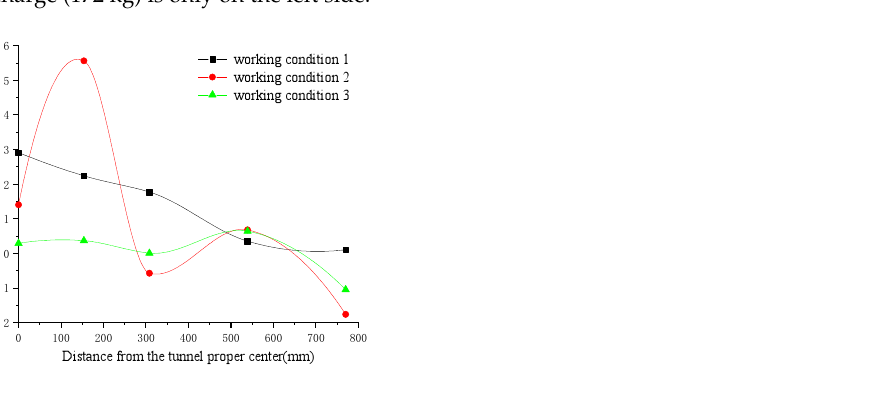
Figure 6. Change in the lateral convergence of each measurement point of the tunnel when the surcharge (both 172 kg) is on two sides.